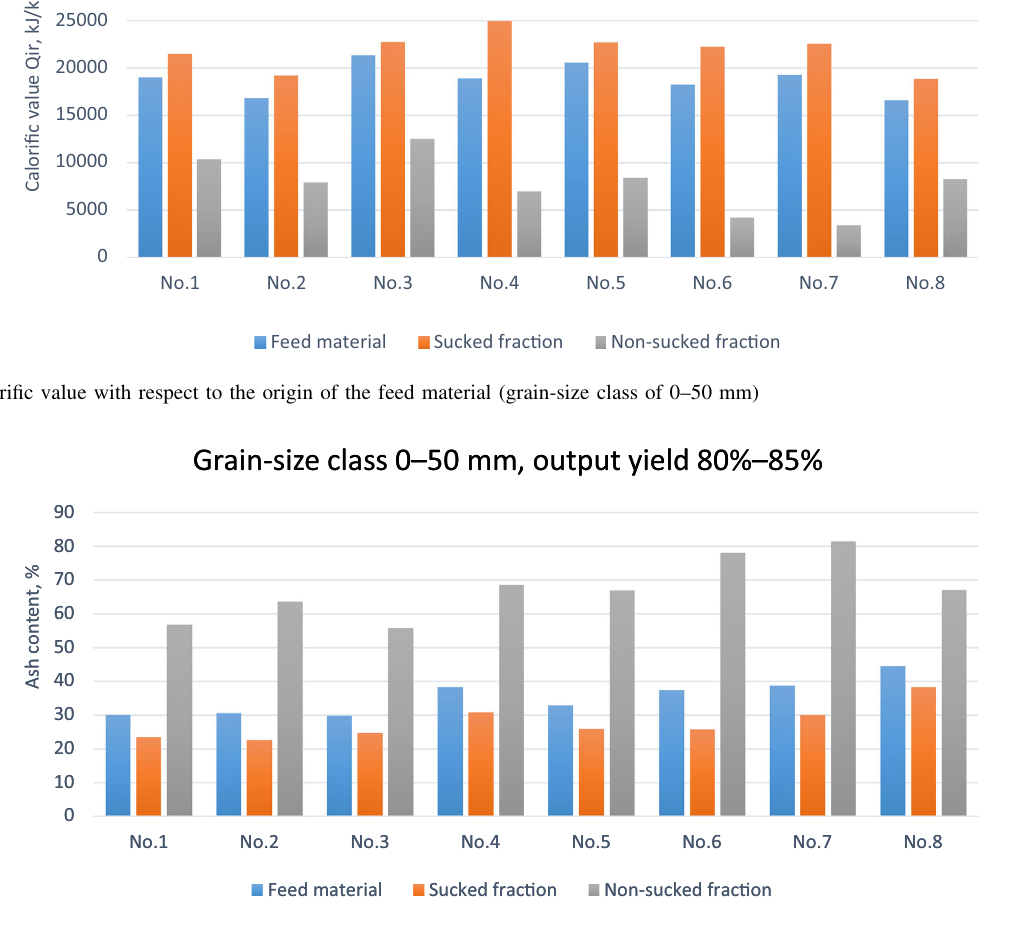
Fig. 12 Ash content with respect to the origin of the feed material (grain-size class of 0–50 mm)